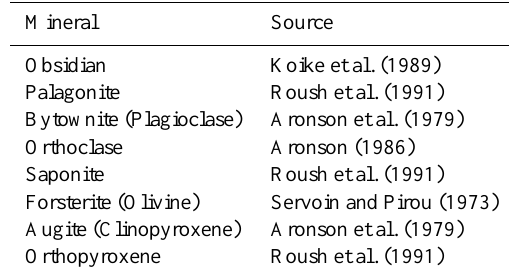
Table 1. Mineral components used in the retrieval and source of optical